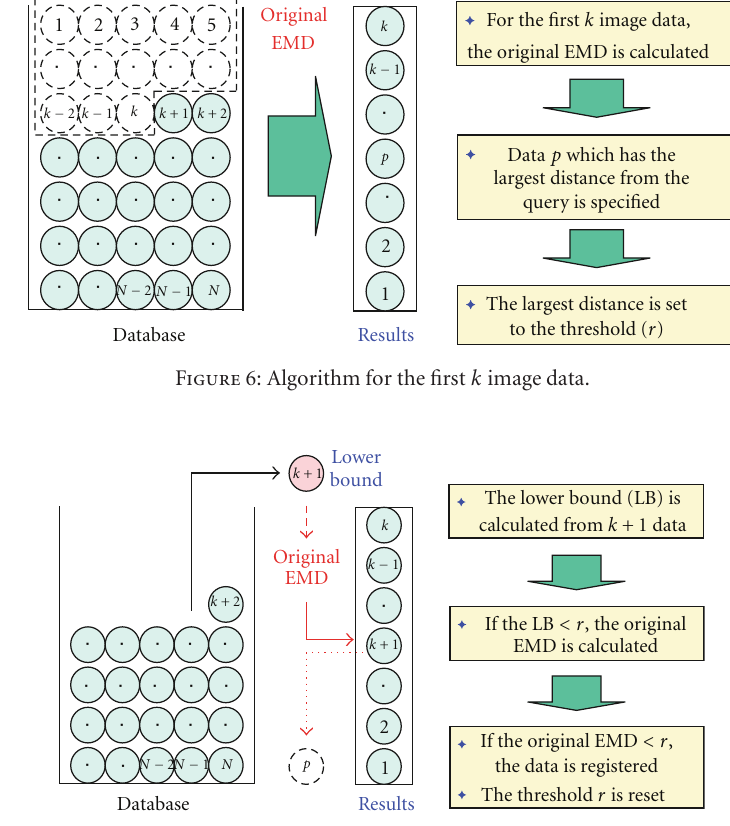
Figure 7: Algorithm from the k + 1 image